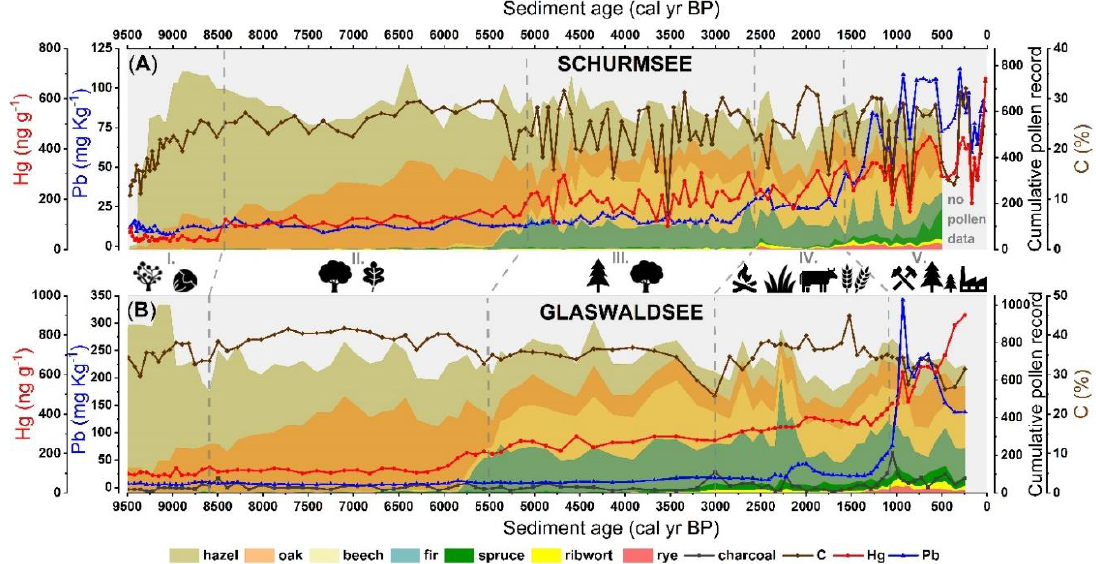
Figure 2. Cumulative historical pollen records for hazel, oak, beech, fir, spruce, ribwort and rye (coloured stacked area) and concentrations of C (brown line), Hg (red line), and Pb (blue line) for Schurmsee ( A ) and Glaswaldsee ( B ) by linear age-depth distribution. In addition, a charcoal record (grey line) is shown for Glaswaldsee, and indicators (black symbols) of the vegetation cover types and human-caused impacts are shown for both catchments.